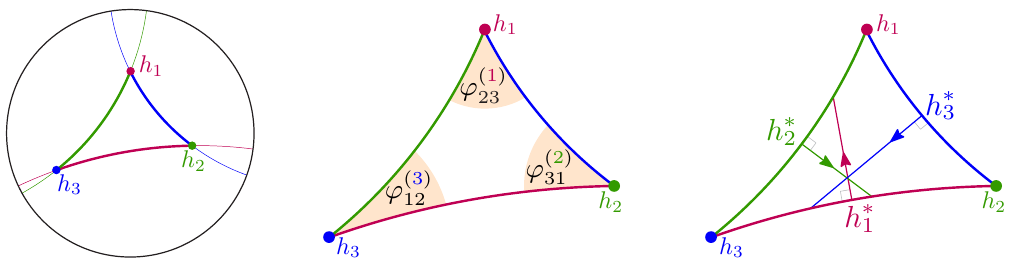
Figure 4 . The vectors and angles de(cid:12)ning a hyperbolic triangle formed by vertices h